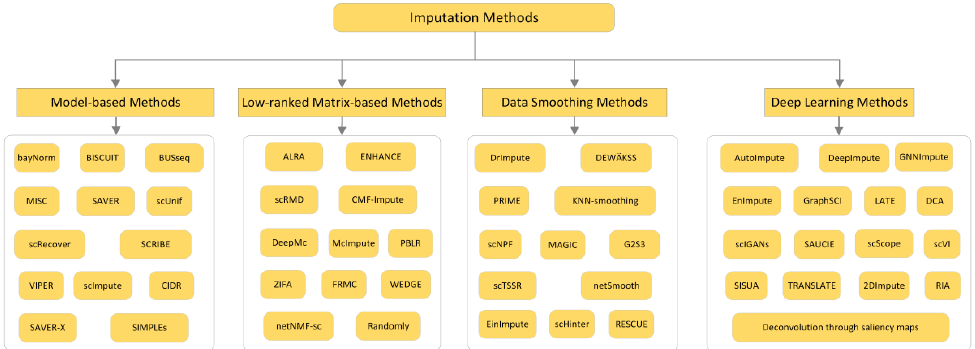
Figure 2. Classification method I of imputation method is divided into model ‐ based method, data smoothing ‐ based method, deep learning ‐ based method and low ‐ rank matrix ‐ based method.